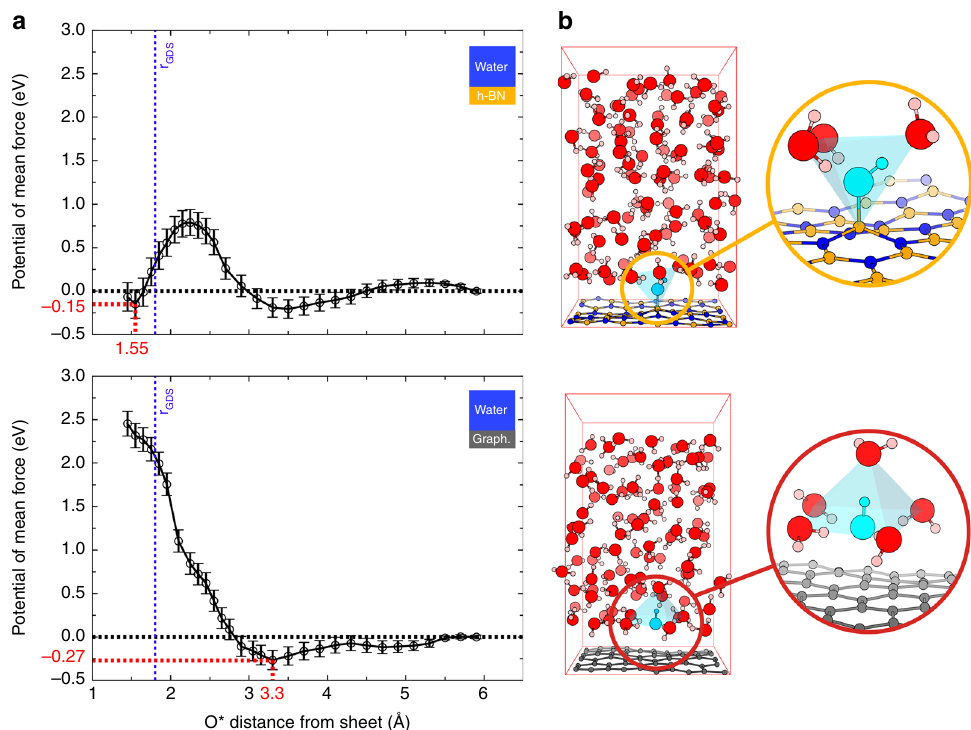
Fig. 2 Free energy pro fi les and stable con fi gurations. a Potentials of mean force of an aqueous hydroxide (O * H) − with respect to the O * distance from the h-BN (top) and the graphene (bottom) sheets. The position of the Gibbs dividing surface (GDS), derived by adapting the calculation of ref. 48 , and the position of the free energy reference are respectively indicated by vertical blue and horizontal black dotted lines. Error bars correspond to standard deviations (see Supplementary Methods). b Atomistic con fi gurations corresponding to the chemisorbed hydroxide on h-BN (top) and the anion physisorbed at 3.9 Å from graphene (bottom) are displayed with details of the solvation shells (insets). The hydroxide, hydrogen, boron, carbon, nitrogen and oxygen atoms are respectively represented in cyan, orange, grey, blue, and